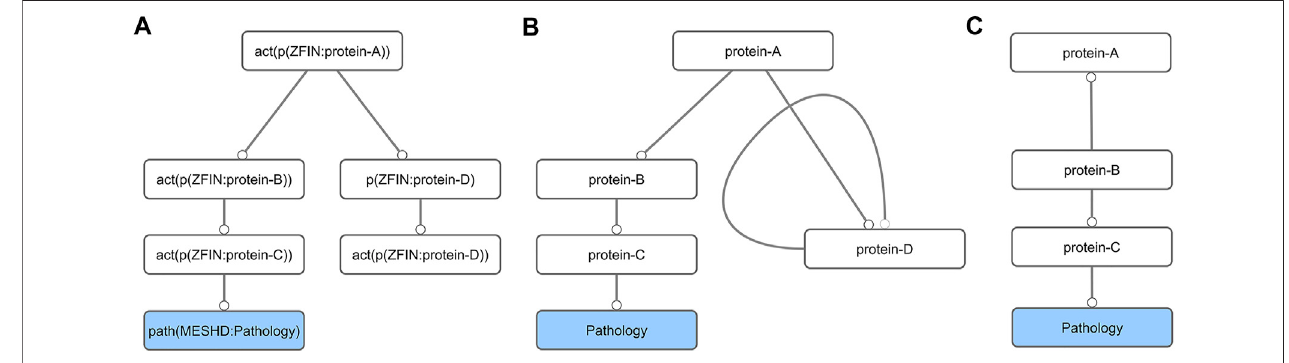
FIGURE1| Schematicdiagramofthenetworkpreparationprocedure.First,theBELnetwork (A) isconvertedintoitsabstractform (B) .Thissimpli fi cationresultsin the formation of self-loops (protein-D), which are removed together with all nodes that do not lead to a pathology node (C)